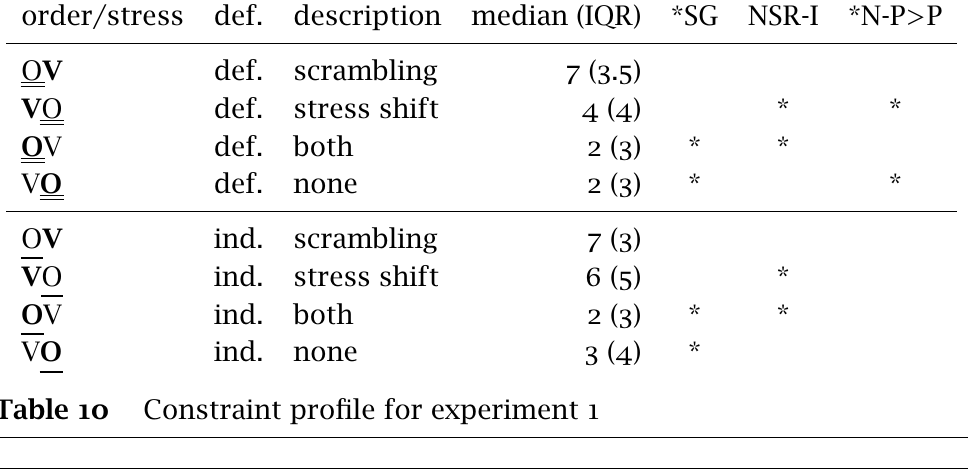
Constraint profile for experiment 1